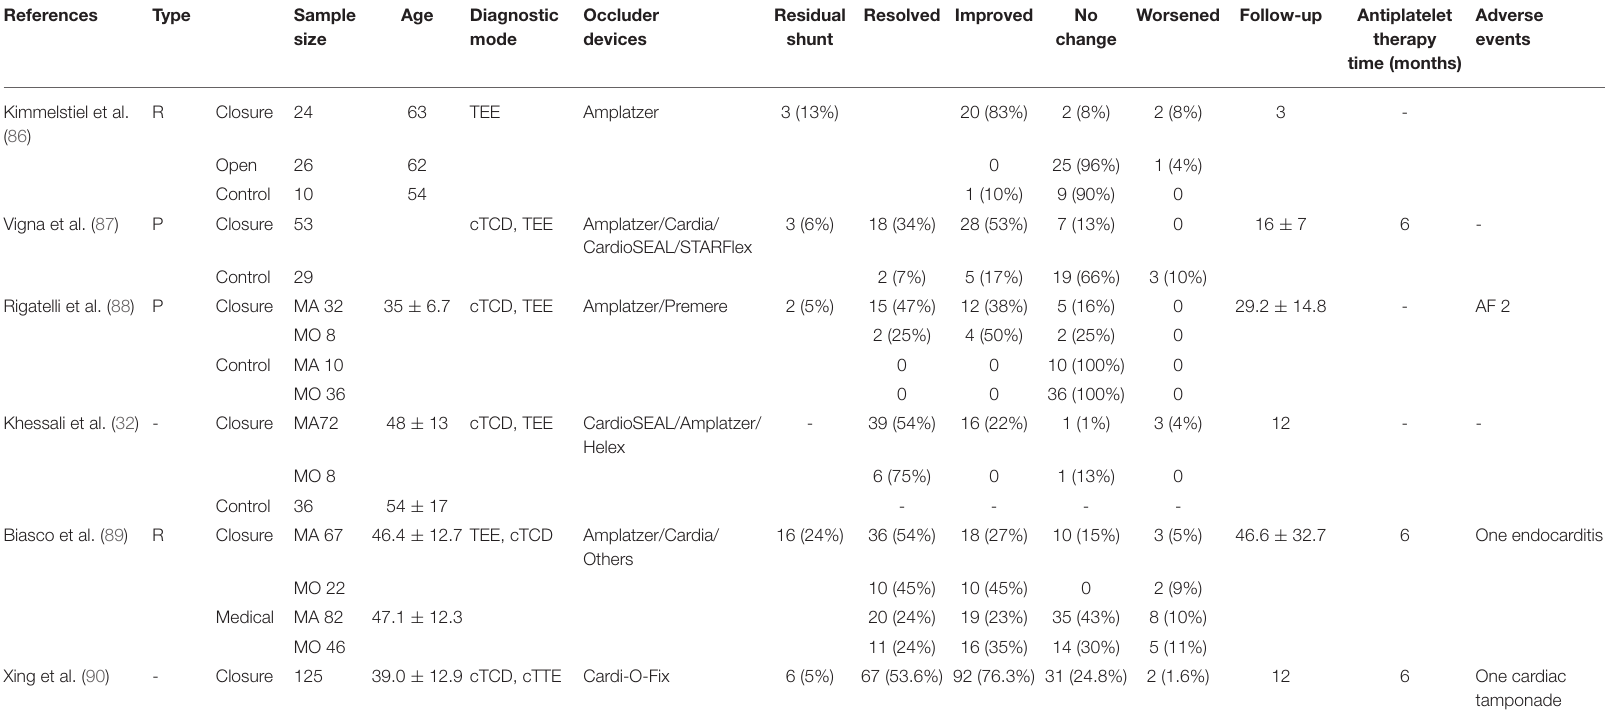
TABLE 2 | The Effect of Patent Foramen Ovale Closure on Migraine in case-control